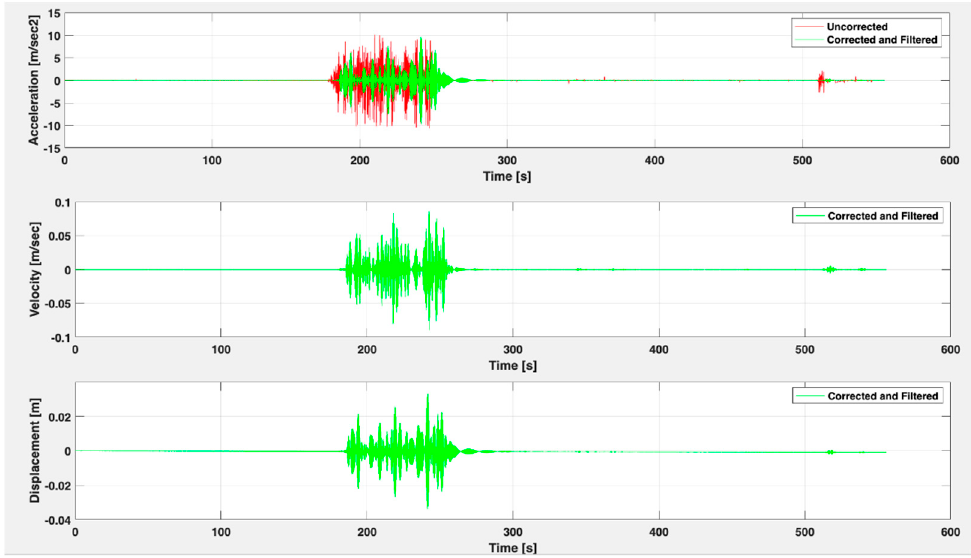
Figure 5. Acceleration, velocity, and displacement display window with baseline correction and filtering.